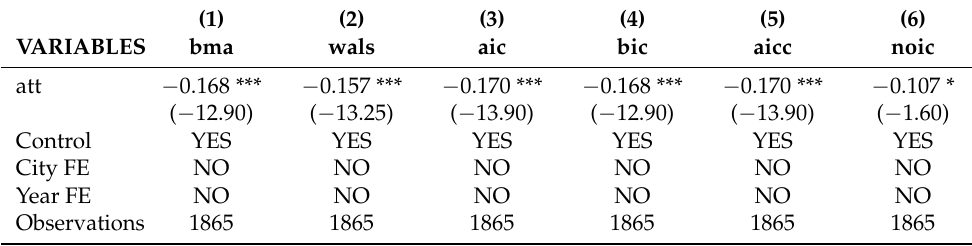
Table 8. Model averaging for